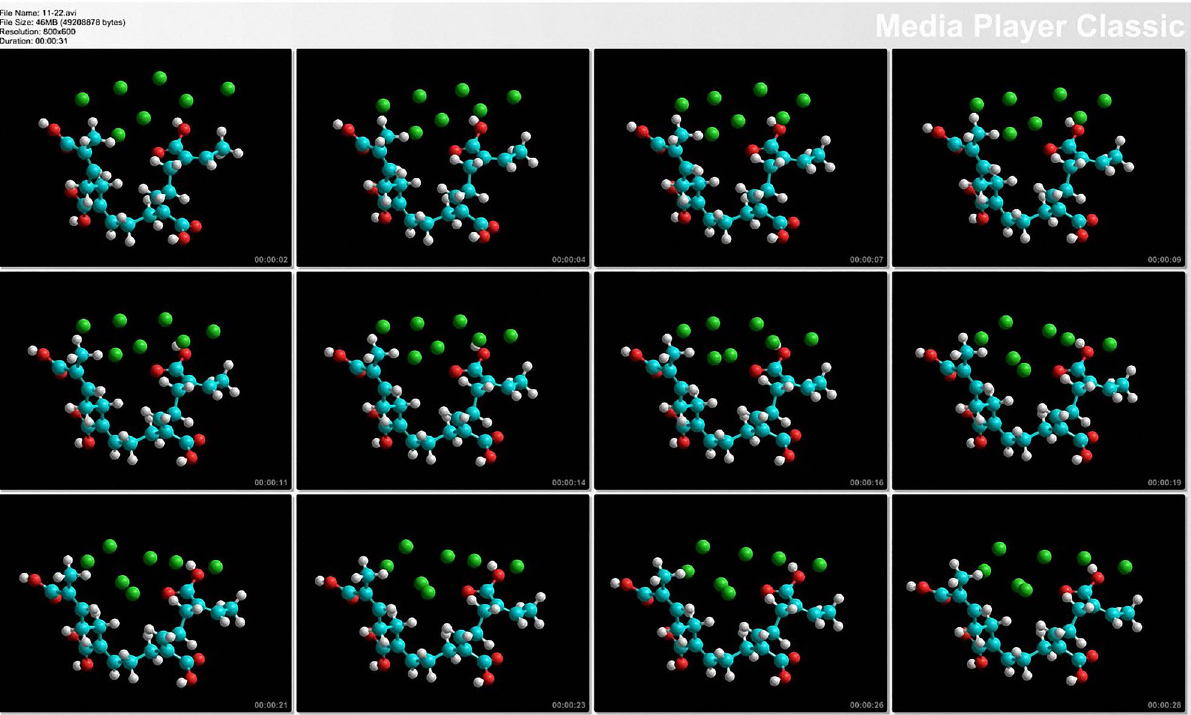
Figure 10. Surface of the molecular dynamics mechanical schematic (O: oxygen in red; C: carbon in blue; H: hydrogen in white; Cu: copper in green) (Version number: